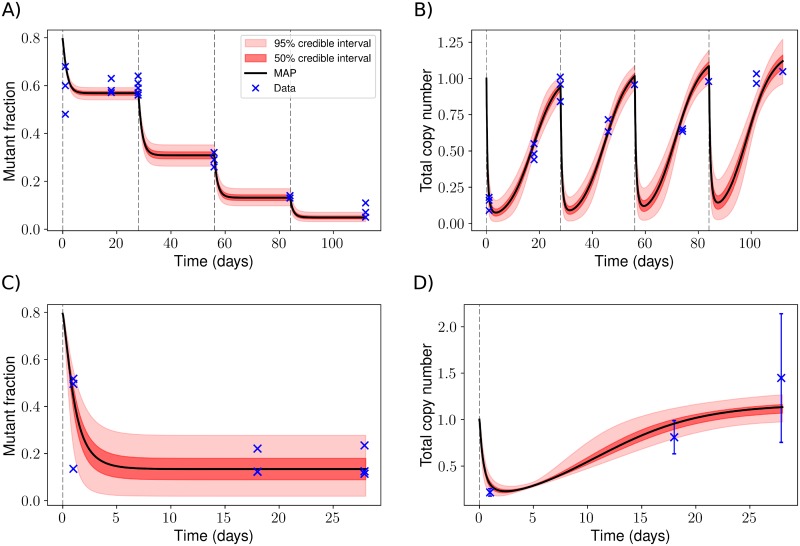
Bayesian credible intervals show the ability of a simple nuclease treatment model to capture experimental observations.We used Metropolis sampling to fit our model parameters to recently obtained experimental data [36]. Solid black lines correspond to the maximum a posteriori (MAP) prediction and vertical dashed lines indicate transfection events (once every 28 days). A: Drawing from our posterior distributions (5 × 104 samples), we show the mean and 50% and 95% credible intervals of our heteroplasmy dynamics predictions during four rounds of treatment and recovery. Deterministic simulations were used. Crosses indicate data points from Ref. citeGammage16Near. B: Similar to figure (A), but showing relative total mtDNA copy numbers. C + D: Heteroplasmy and copy number dynamics were measured during a single round of treatment and recovery in a setting in which the mtZFN concentration was reduced by incorporating hammerhead ribozymes in the mtZFN backbone [36]. The credible intervals shown were obtained by sampling from the posterior distributions of the parameters I0, b, c1 and δ obtained using the data in figures (A) and (B), and using ξ ∼ 0.15 which represents the maximum likelihood estimate of ξ using this low mtZFN concentration data (Methods). Error bars in figure (D) show standard deviations of experimental measurements [36].